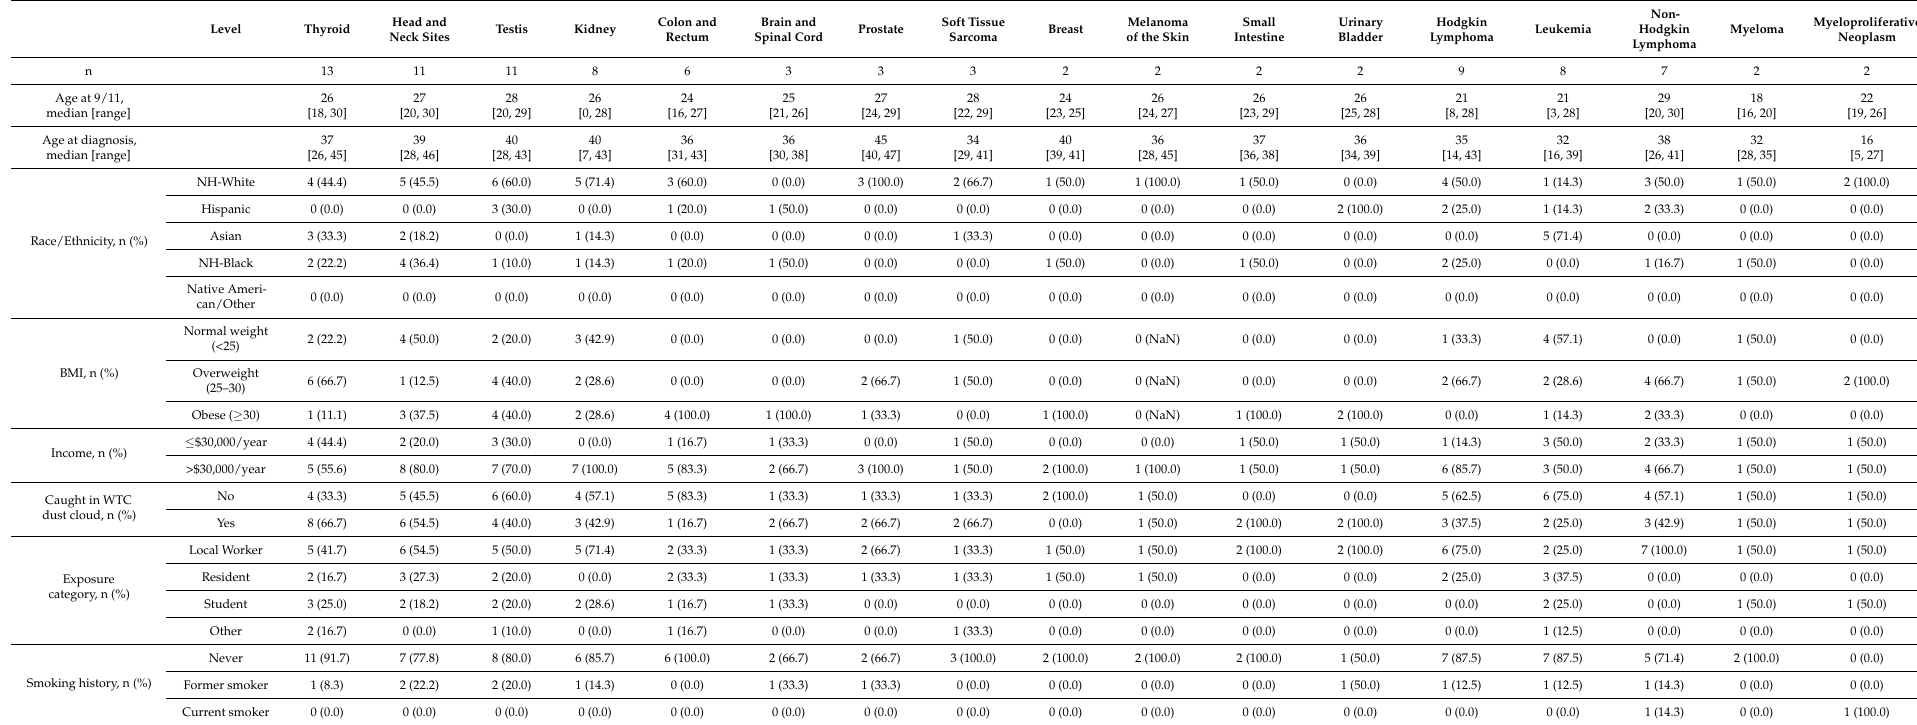
Table A2. Characteristics of male EYA diagnosed with the most common cancers included in the WTC EHC cancer analysis (as of 31 July 2021). Level Thyroid Headand NeckSites Testis Kidney Colonand Rectum Brainand SpinalCord Prostate SoftTissue Sarcoma Breast Melanoma oftheSkin Small Intestine Urinary Bladder Hodgkin Lymphoma Leukemia